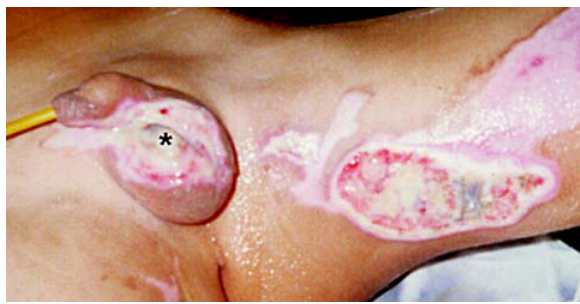
Figure 1 – Aspect of the genitalia 72 hours after the electric burn. Note the area of necrotic tissue in the scrotum. (*).